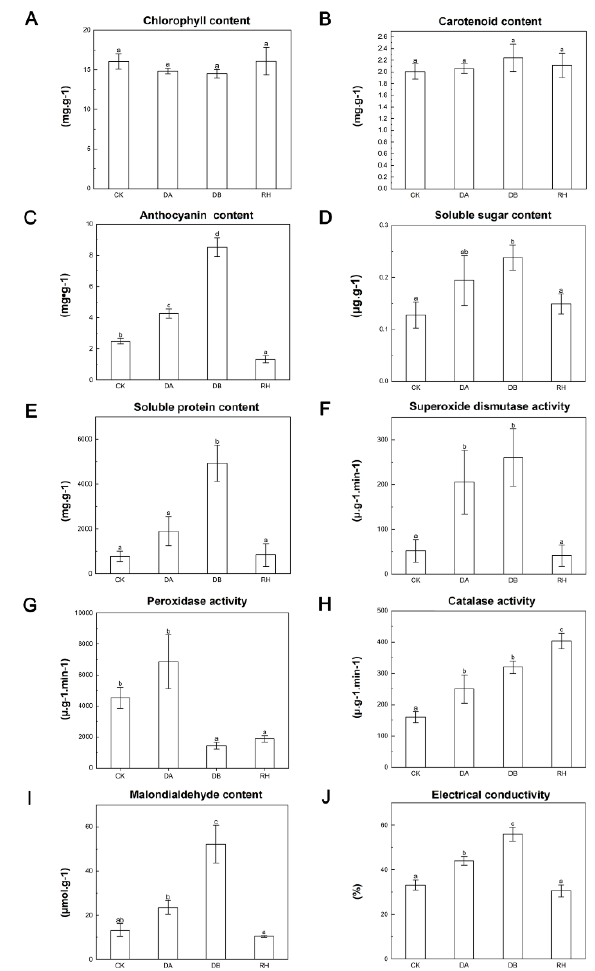
Figure 2. Changes in the physiological traits of B. ciliata ‘Qiuhong’ leaves under different drought treatments. ( A ) Content of chlorophyll; ( B ) Content of carotenoid; ( C ) Content of anthocyanin; ( D ) Content of soluble sugar; ( E ) Content of soluble protein; ( F ) Superoxide dismutase (SOD) activity; ( G ) Peroxidase (POD) activity; ( H ) Catalase (CAT) activity; ( I ) Content of malondialdehyde (MDA); ( J ) Electrical conductivity. The x-axis corresponds to the control (CK), 15-day drought treatment (DA), 30-day drought treatment (DB), and rehydration (RH) groups. Data represent the mean ± SD ( n = 3). Different lower letters indicate significant differences at the p < 0.05 level according to Tukey’s test.